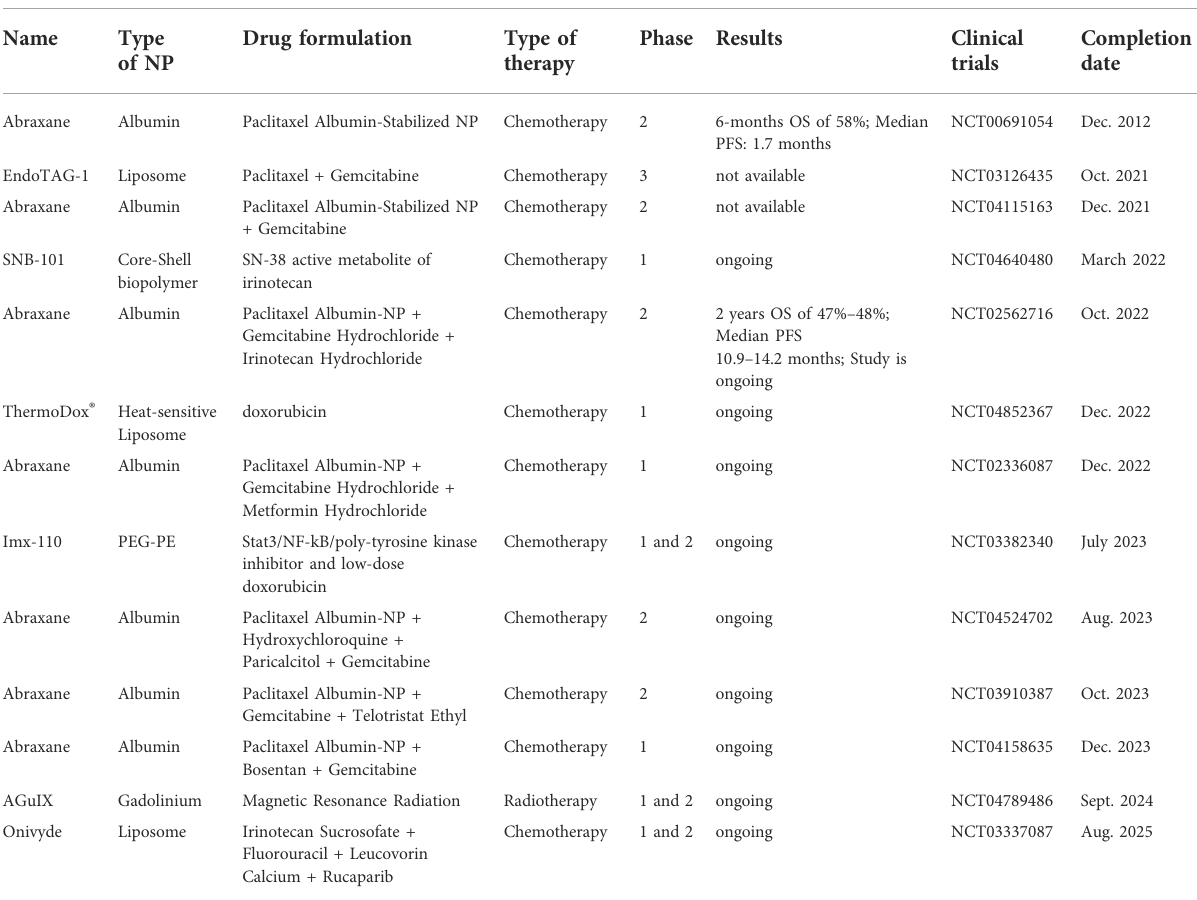
TABLE 1 Clinical trials of NP-based chemo- or radiotherapy for pancreatic cancer. Chemotherapeutic or